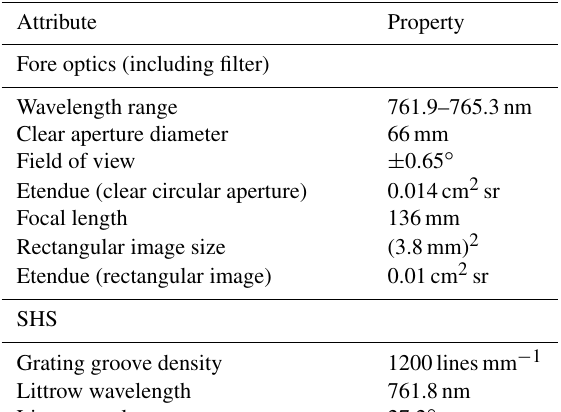
Figure 4. Simulated interferogram of the O 2 A-band nighttime emission for various altitudes.